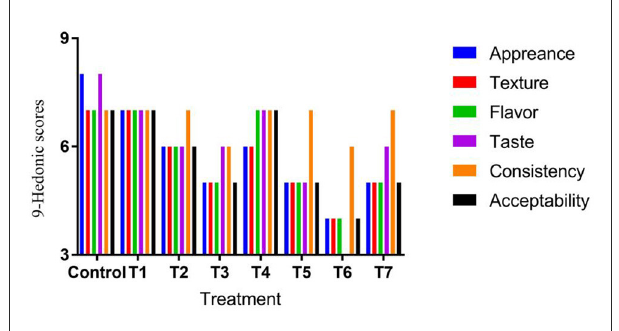
FIGURE1 SPP and MPP effects on the rheological properties of functional yogurt.